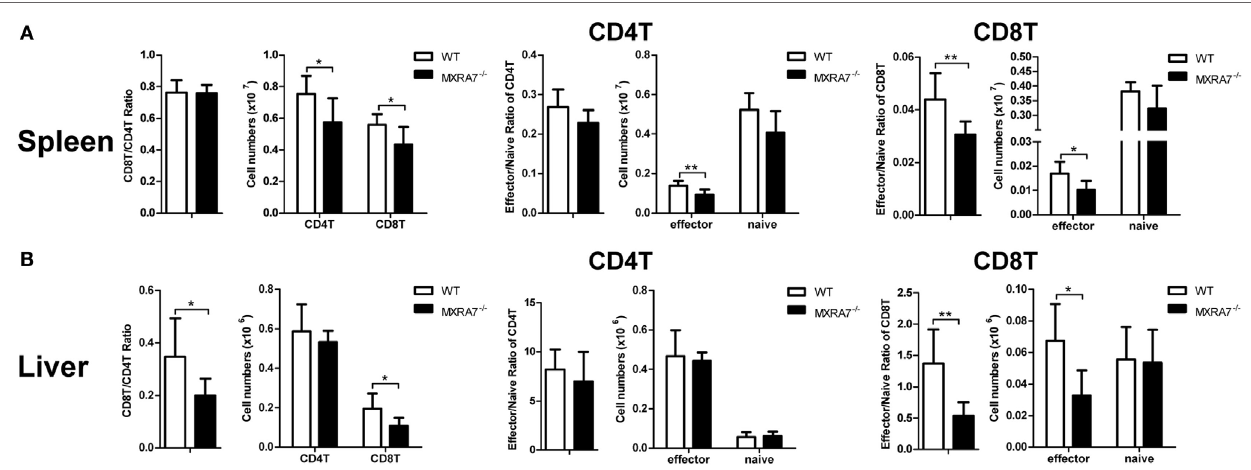
FigUre 3 | Matrix remodeling associated 7 (MXRA7) deficiency decreases the numbers of CD8 + T cells. Mice from wild-type (WT) and MXRA7 − / − groups ( n = 7 each group) were sacrificed 24 h after 1 ml/kg CCl 4 injection. Splenocytes and intrahepatic leukocytes were isolated for FACS analysis. (a) Flow cytometric analysis showing slight but statistically significant decrease of CD8 + T cells and effector cells (CD62L - CD44 + ) in CD4 + T, CD8 + T cells in spleen. (B) Flow cytometric analysis of CD4 + T and CD8 + T cells, and effector cells (CD62L − CD44 + ) in liver. Data shown are the representative of three independent experiments. * p < 0.05, ** p < 0.01.